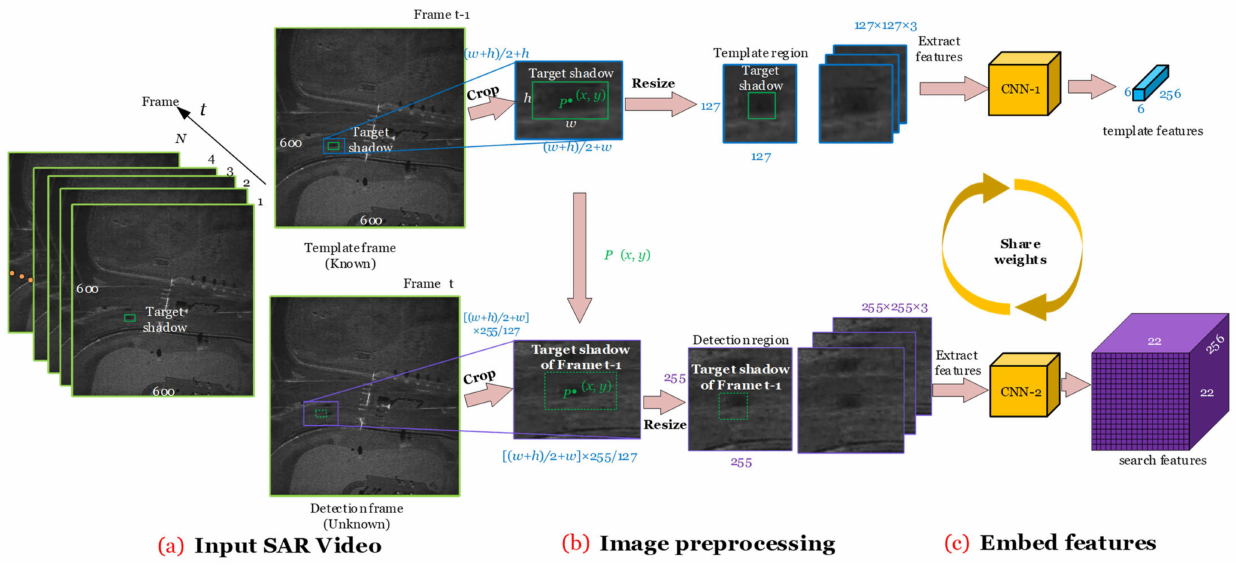
Figure 6. Image preprocessing and feature embedding. Input SAR Video ( a ), preprocess image ( b ), embed features ( c